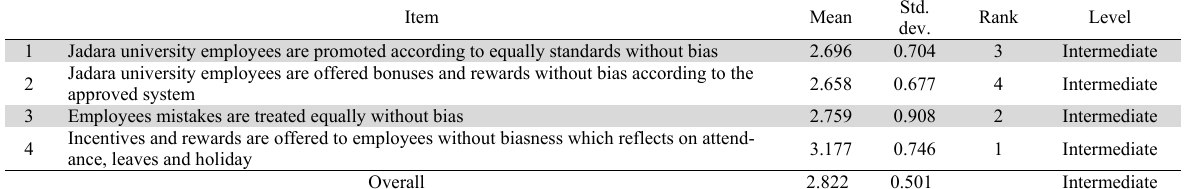
The mean and standard deviation of the factors associated with incentives and rewards